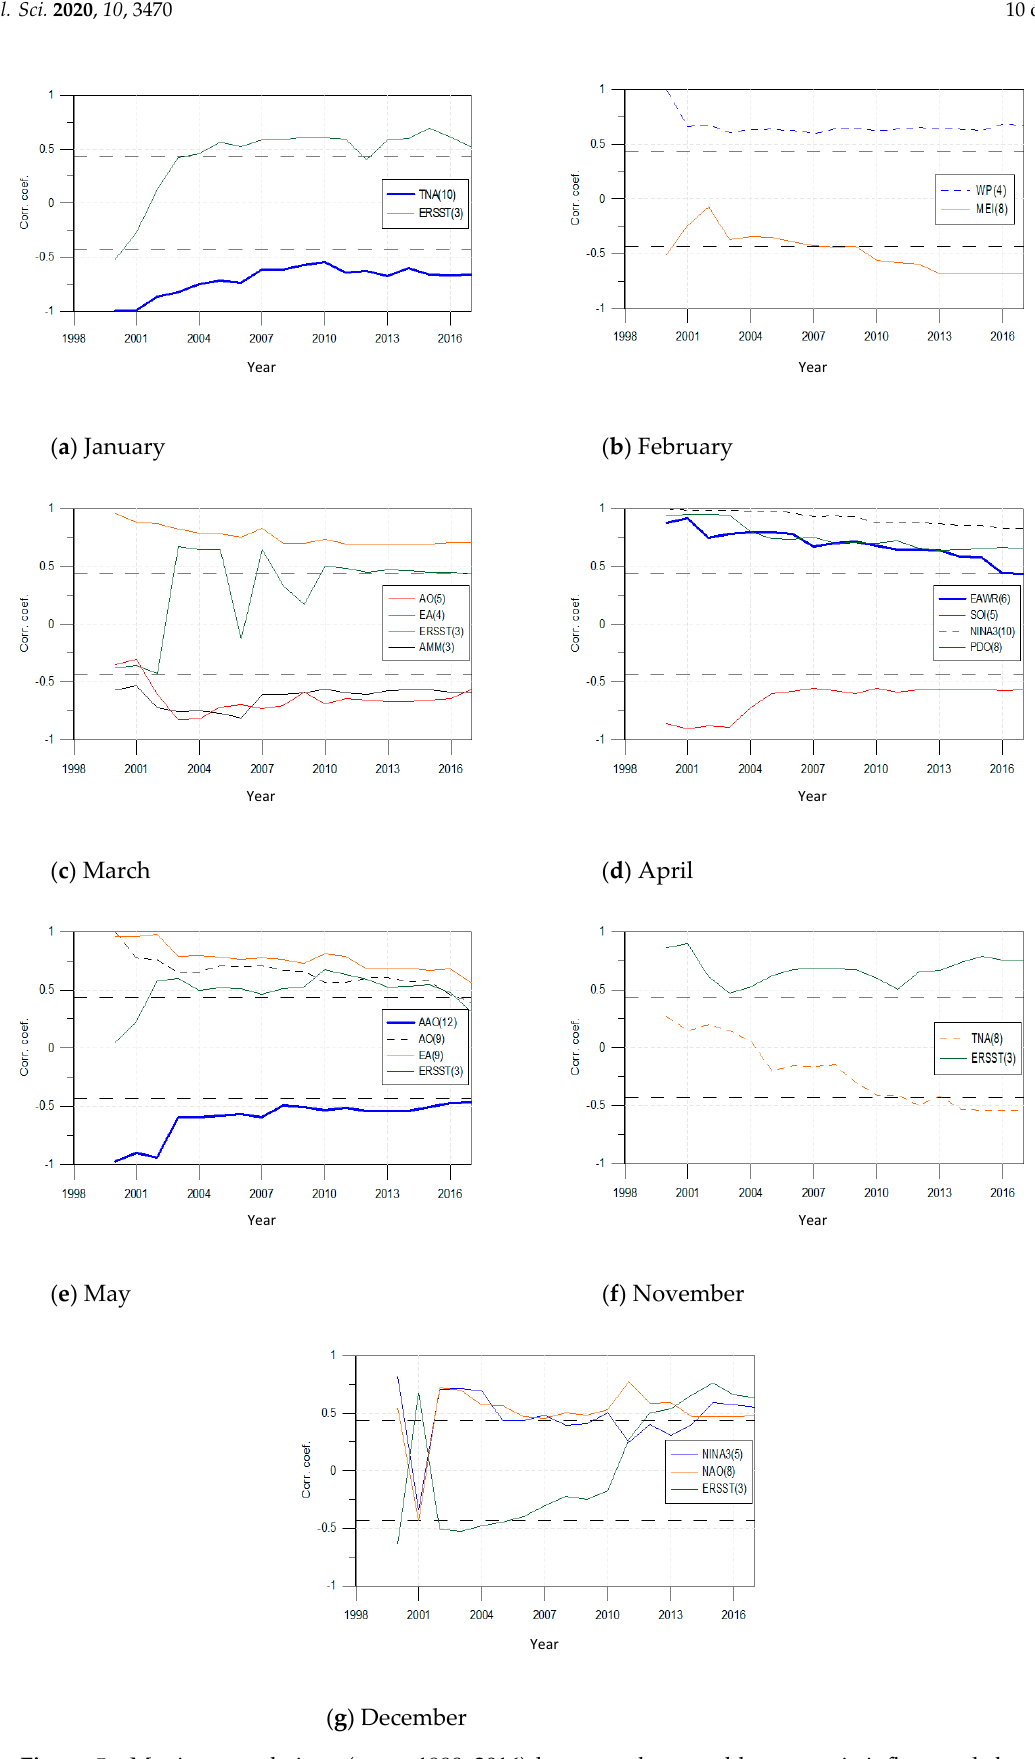
Figure 5. Moving correlations (years 1998–2016) between the monthly reservoir inflow and the climatic indices.